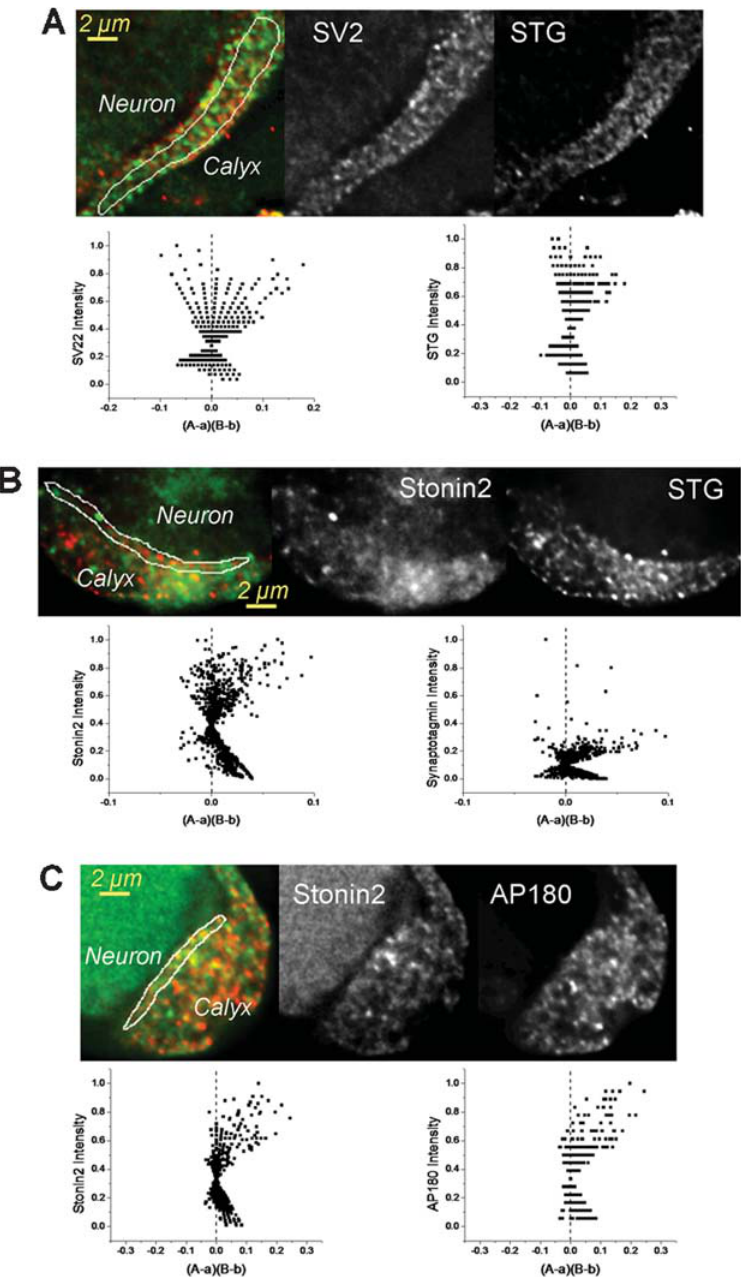
Figure 7. Localization of the SAE complex at the transmitter release face. Isolated chick ciliary ganglion calyx synapses were immunostained with antibodies against protein pairs. We used ICA plots to test for staining covariance (plot of normalized pixel intensity for each immunostain against the ( A-a )( B-b ) function, where A and B are the normalized pixel intensities for stain A and B and a and b are their respective means) in which a left skew indicates segregated staining, a symmetrical plot random staining and a right skew staining intensities that covary (see Methods ). A. Calyx stained for secretory vesicle marker SV2 ( green,leftpanel ) and STG 1 (STG; red,leftpanel ) with ICA plots as labeled. The presynaptic calyx and postsynaptic neuron are indicated. The leftpanel is an overlay of the two black/white images. The ICA plots are for SV2 versus STG ( leftpanel ) and STG versus SV2 ( rightpanel ). B. As in A but staining for STG ( red,leftpanel,leftICAplot ) and the SAE component, stonin2 ( green,leftpanel,rightICAplot ). C. As in A but staining for Stonin2 ( green,leftpanel,leftICAplot ) and AP180 ( red,leftpanel,rightICAplot ).